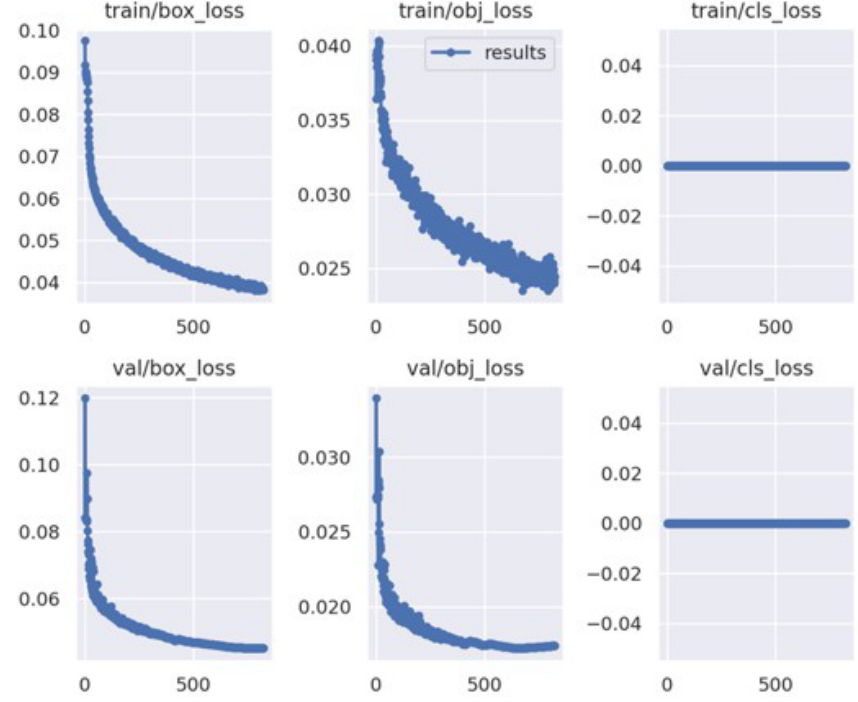
Figure 13. Comparison training vs. validation Loss with and without